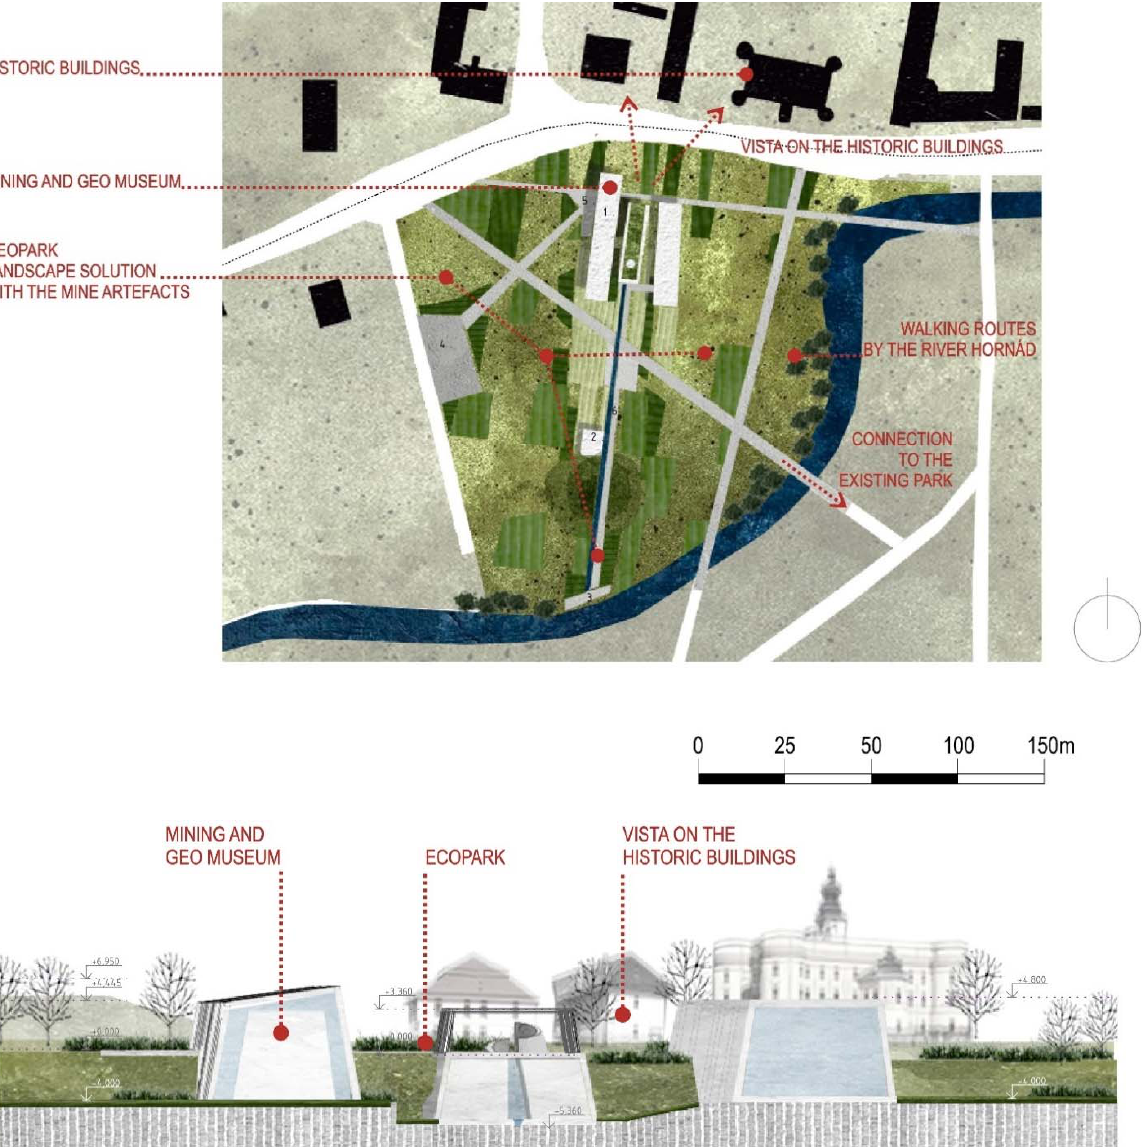
Figure 12. The concept heightened the mining and landscape. Case Study 2a—situation and view (author’s design studio, K. Záveská).